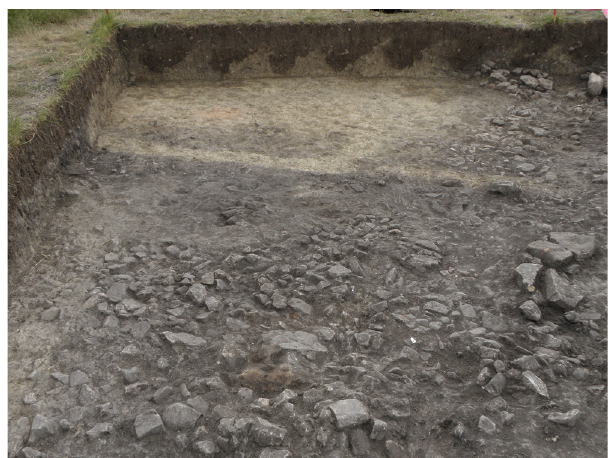
Figure 6: Segment of damaged upper part of the deposit at Barice in Benkovac ( photo: D. Vujevi ć )